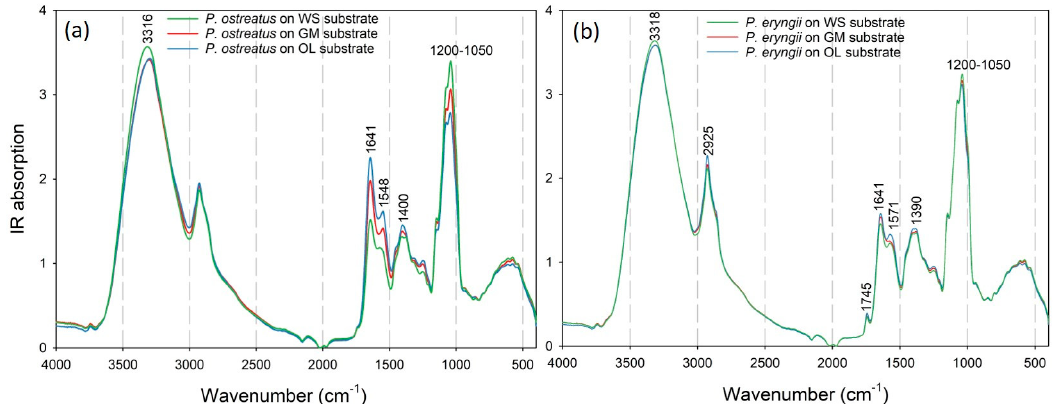
Figure 2. Recorded attenuated total reflectance (ATR)-FTIR spectra of ( a ) Pleurotus ostreatus and ( b ) P. eryngii mushrooms cultivated on wheat straw (WS), wheat straw plus grape marc mix, 1:1 w/w (GM) and two-phase olive mill waste plus olive leaves, 1:1 w/w (OL) substrates.